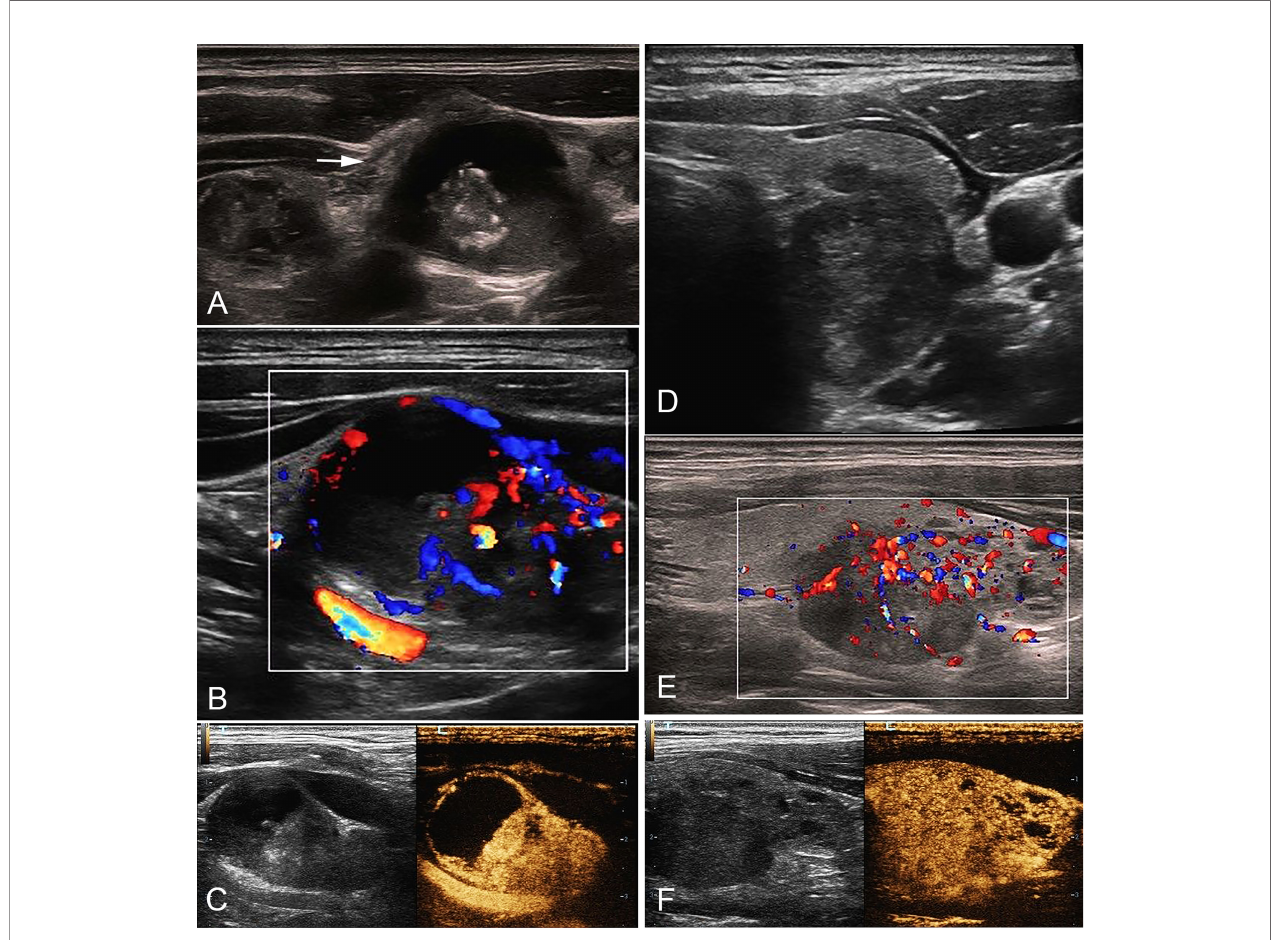
FIGURE 2 | A 35-year-old male with cN1 PTC. (A) Sonogram of the largest metastatic lymph node (arrow) in level IV indicates irregular margin, loss of hilum, calci fi cation, hyper-echogenicity, and cystic change in the node. (B) CDFI shows non-hilar vascularization. (C) CEUS indicates heterogeneous hyper- enhancement and perfusion defect in the node. (D) Sonogram of the PTC lesion shows a solid hypo-echogenic nodule with irregular margin and a taller than wide shape, measuring 1.2*1.4*1.9cm. (E) CDFI indicates abundant blood fl ow signals. (F) CEUS shows that the PTC lesion presents pervasive